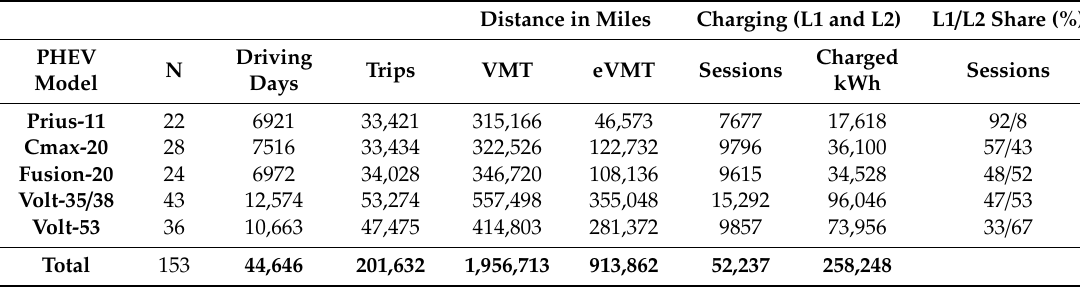
Table 1. Aggregate driving and charging data.